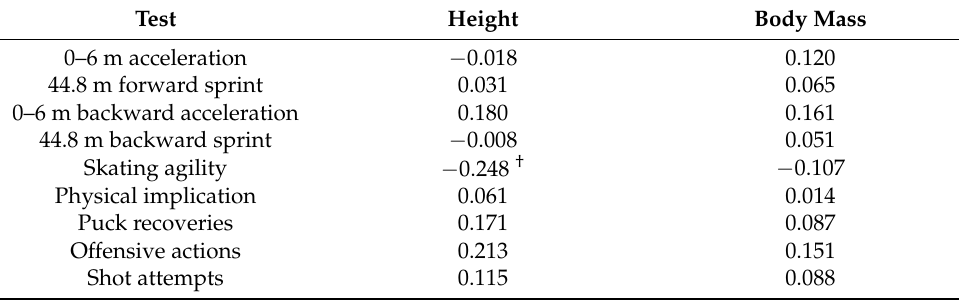
Table 6. Associations between anthropometry and on-ice fitness.